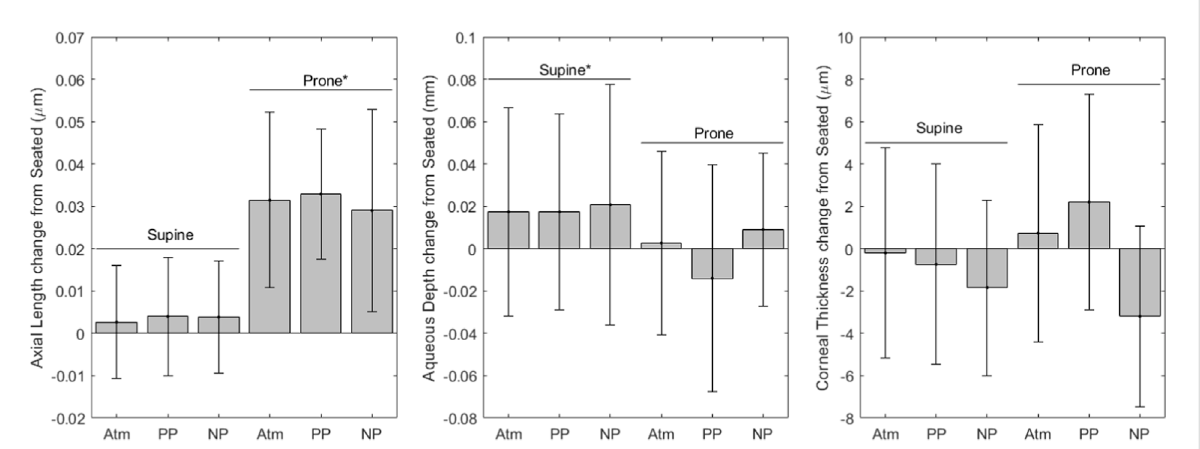
FIGURE 4 Optical Biometer change from seated measurements (* indicates signi fi cance, error bars indicate standard deviation, Atm = no lower body pressure, PP = lower body positive pressure, NP = lower body negative pressure).